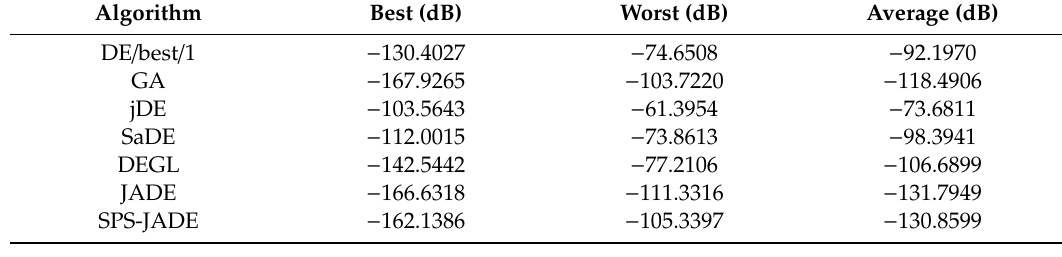
Table 5. Synthesis results of the normalized null depths for the linear antenna array with sidelobe suppression and null depth.